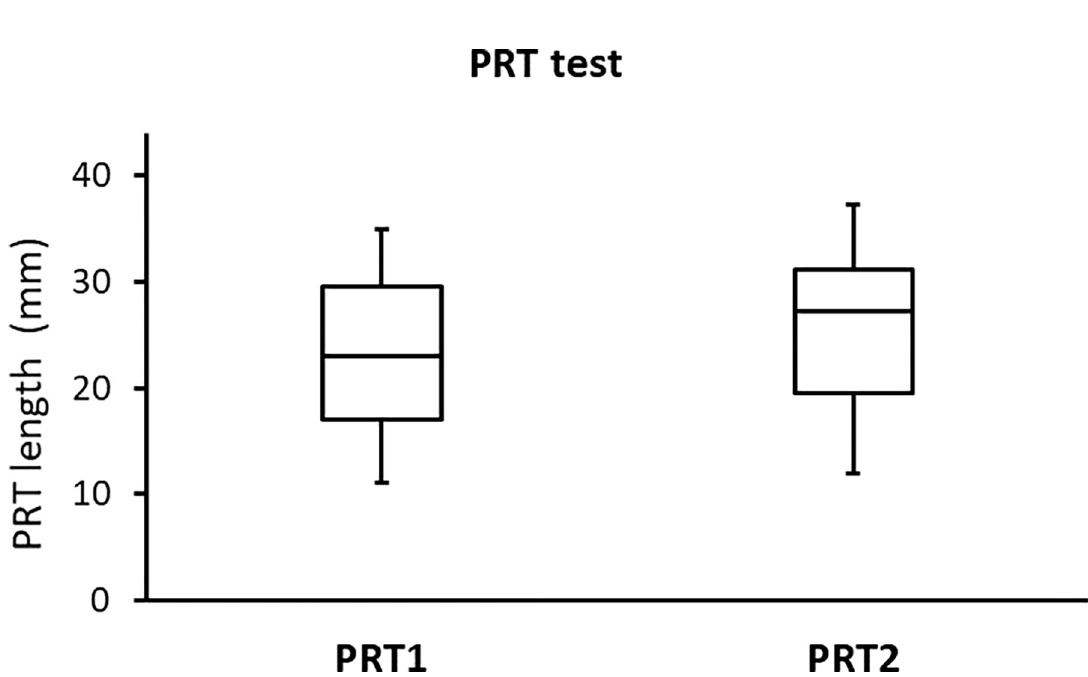
Fig 2. Side-by-side boxplots for the PRT scores for the subjects with a high BMI before (PRT1) and after (PRT2) wearing a surgical face mask.